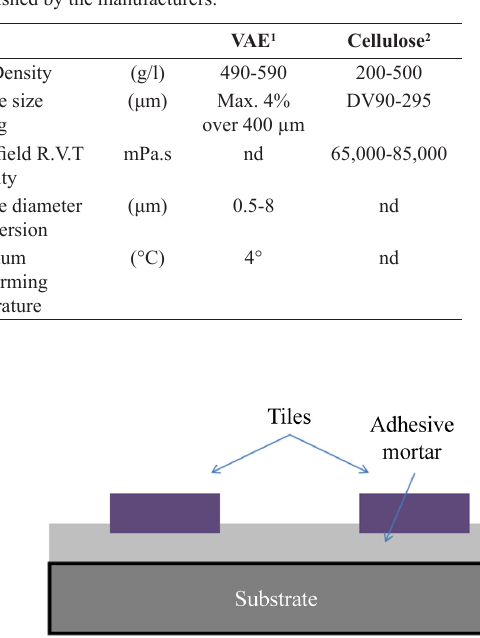
Table 2. The properties of the polymers used in the experiments, as published by the